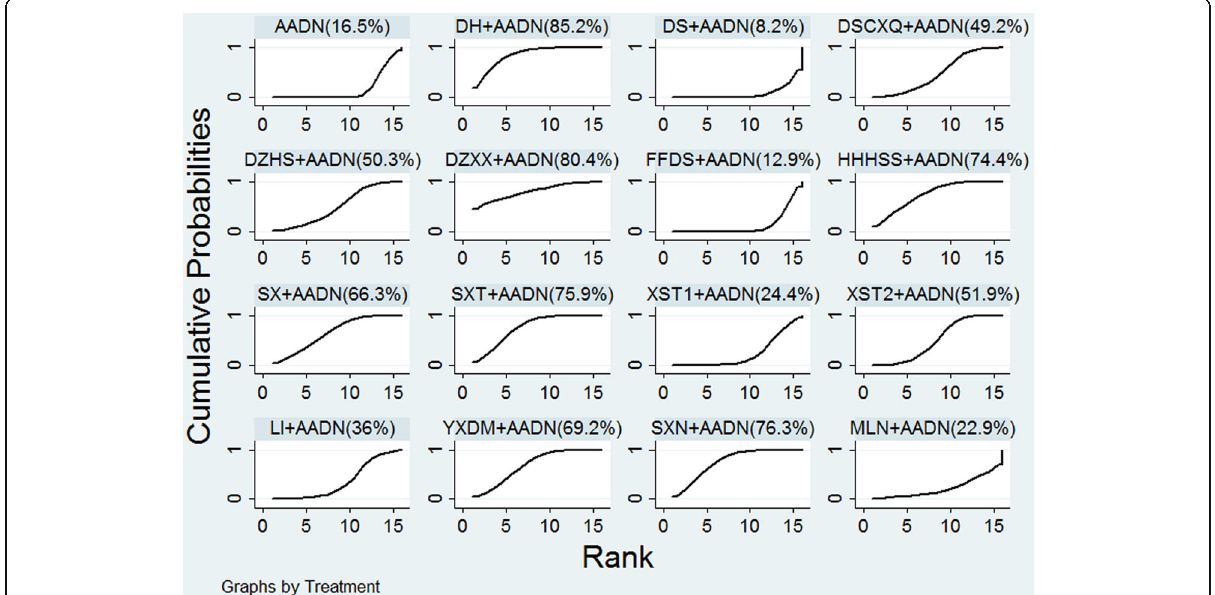
Fig. 5 SUCRA for the markedly effective